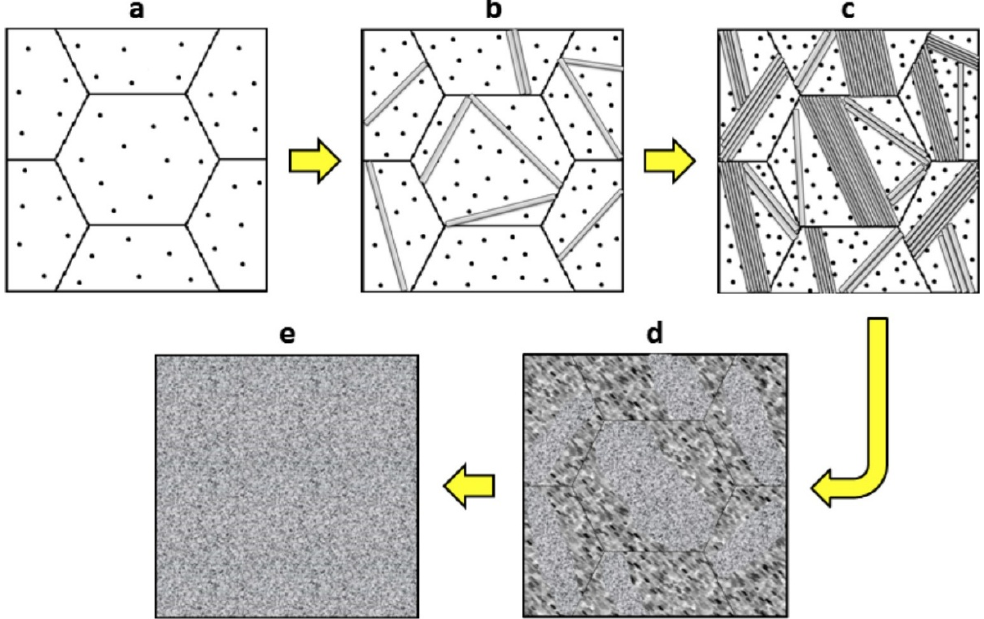
Figure 8. Schematic illustration of microstructural evolution during cold deformation of ASSs through the sequence of ( a ) initial equiaxed austenite grains, ( b ) an increase in dislocation density in γ phase and the initiation of SIM formation, ( c ) decrease in lath width and packet size of SIM, ( d ) transition of lath-type martensite to dislocation-cell-type martensite simultaneous with increase in dislocation density and formation of fresh SIM and ( e ) spreading of dislocation-cell-type martensite.